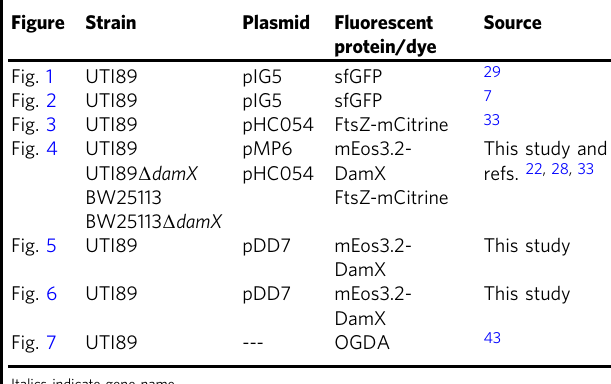
Table 1 Table of fi gures and sources of bacterial strains and plasmids. Figure Strain Plasmid Fluorescent